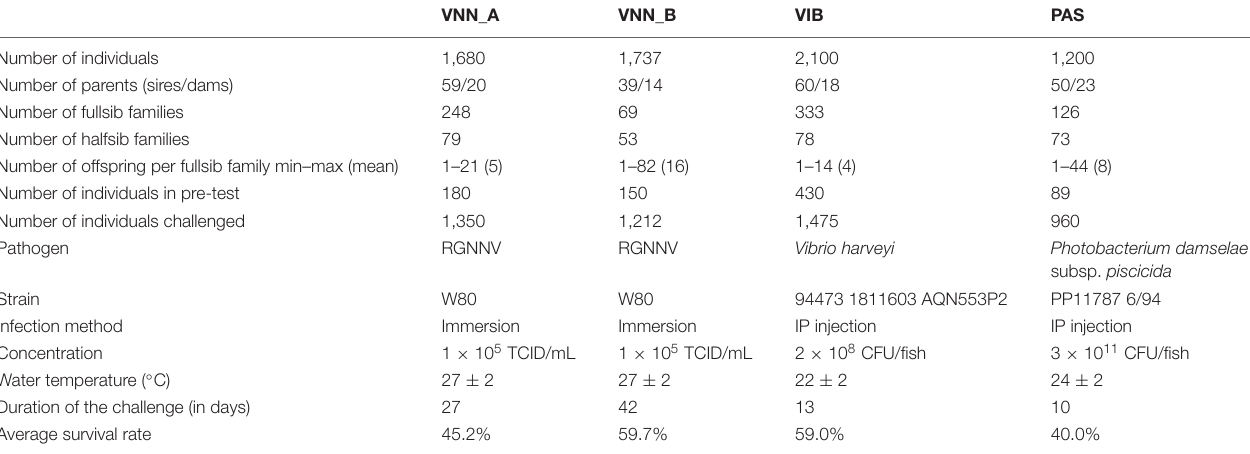
TCID, tissue culture infectious dose; CFU, colony forming